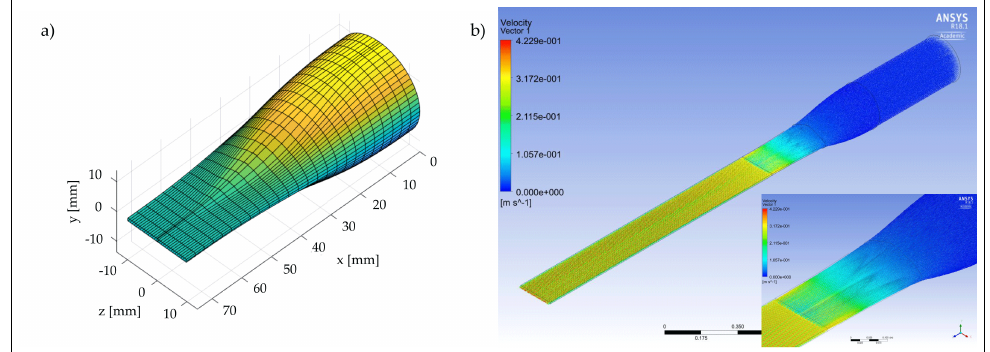
Figure 2. ( a ) Geometry of the convergent section and ( b ) result of a CFD simulation performed inside the fluid-dynamic convergent, connection and test